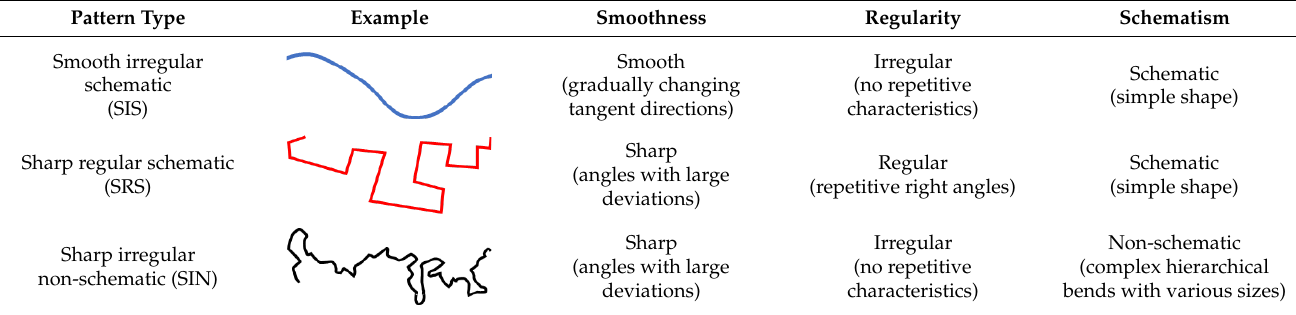
Table 1. Line characteristics of pattern types for administrative boundary segments.